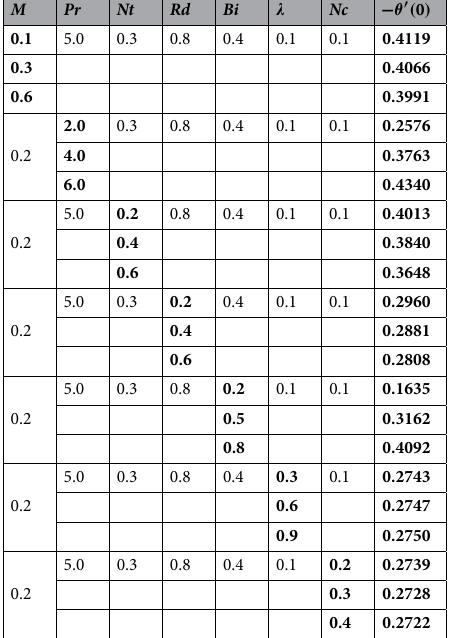
Table 2. Visualizes the significance of M, Pr, Nt, Rd, Bi, ⅄ , and Nc on local Nusselt number. Significant values are in [bold].